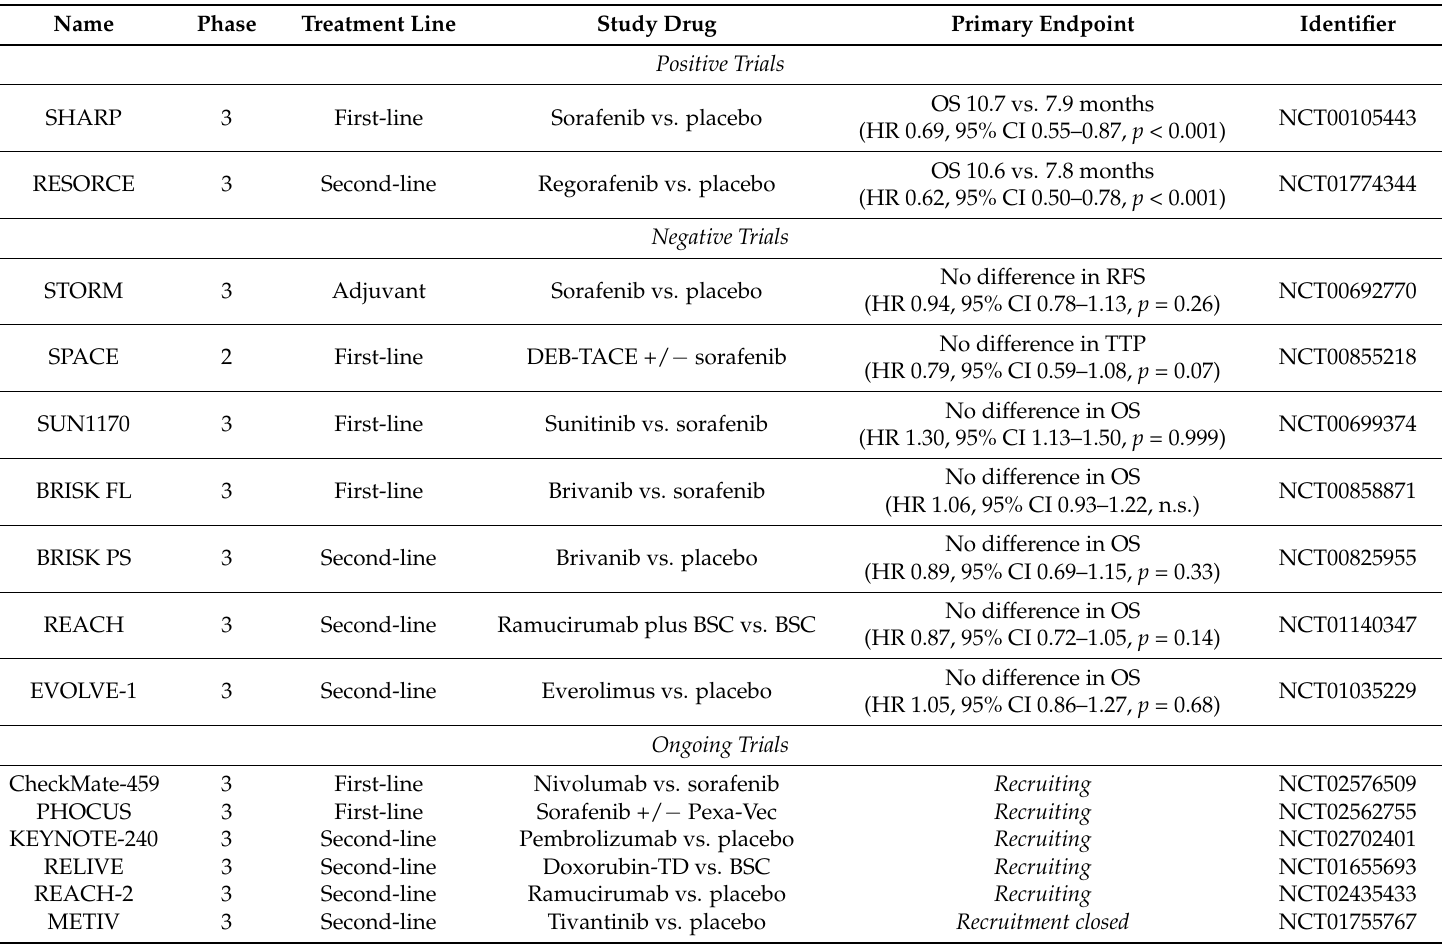
Table 1. Selected clinical trials investigating systemic therapy of